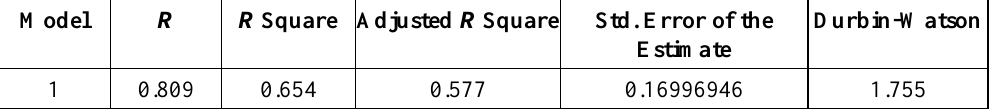
Table 1. Summary of statistical indicators (Author’s computation, 2019) Model R R Square Adjusted R Square Std. Error of the